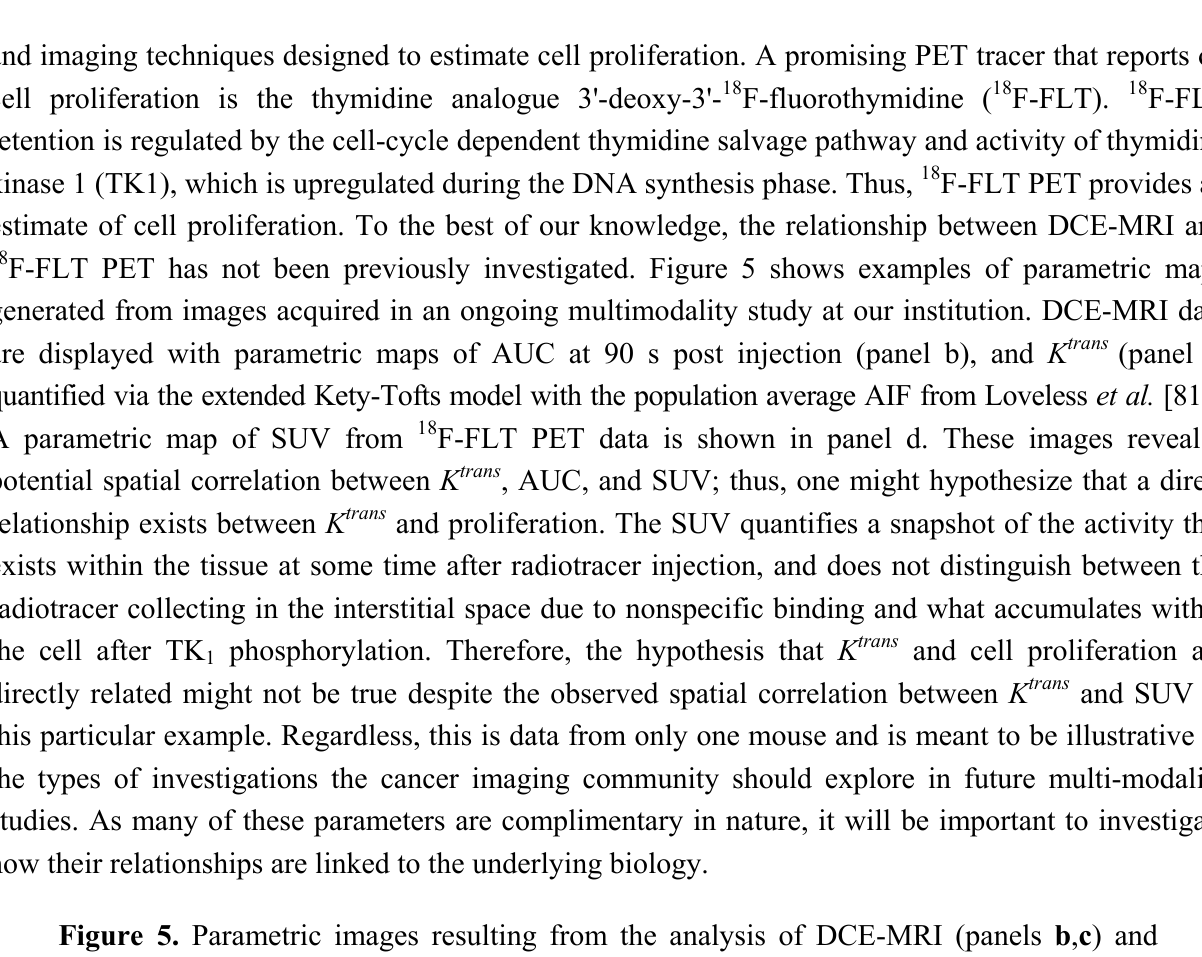
Figure 5. Parametric images resulting from the analysis of DCE-MRI (panels b , c ) and 18 F-FLT data (panel d ). A T -weighted MR anatomical shows the entire imaging field 2